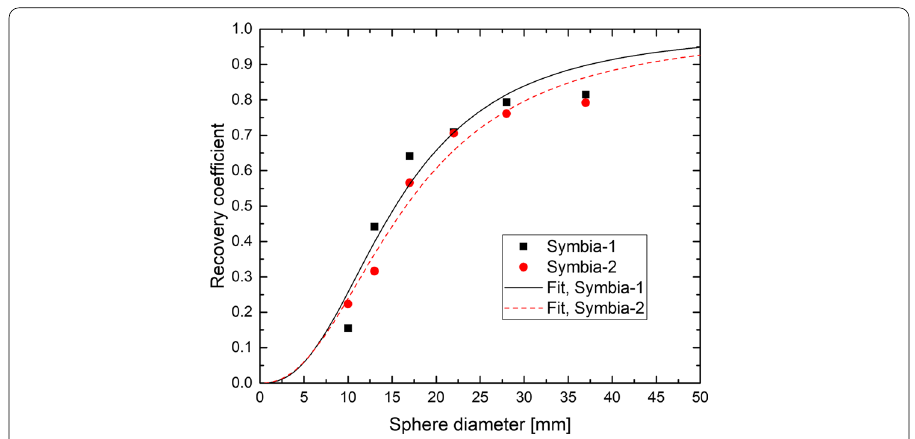
Fig. 4 Recovery coefficients for the spheres in the NEMA NU-2 2001 image quality phantom [37] for Symbia-1 and Symbia-2 and fitted curves of Eq.